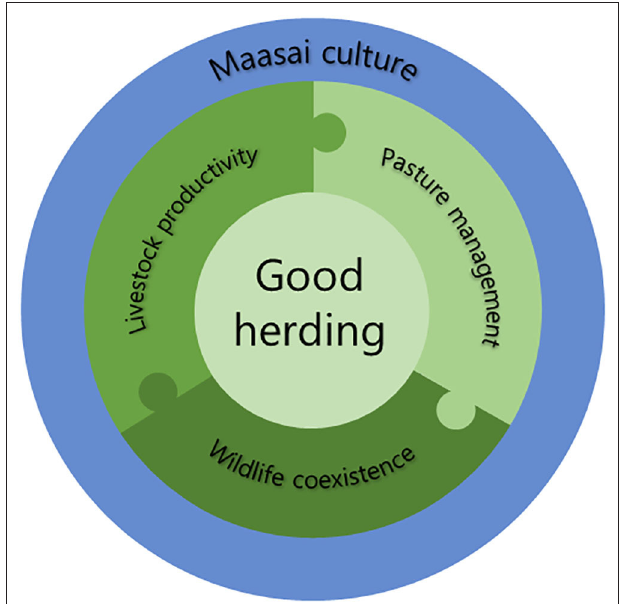
FIGURE 4 | Good herding simultaneously and synergistically achieves livestock productivity, effective pasture management, and wildlife coexistence. These outcomes are inextricably bound and are held together by traditional Maasai culture. At the same time, good herding also supports